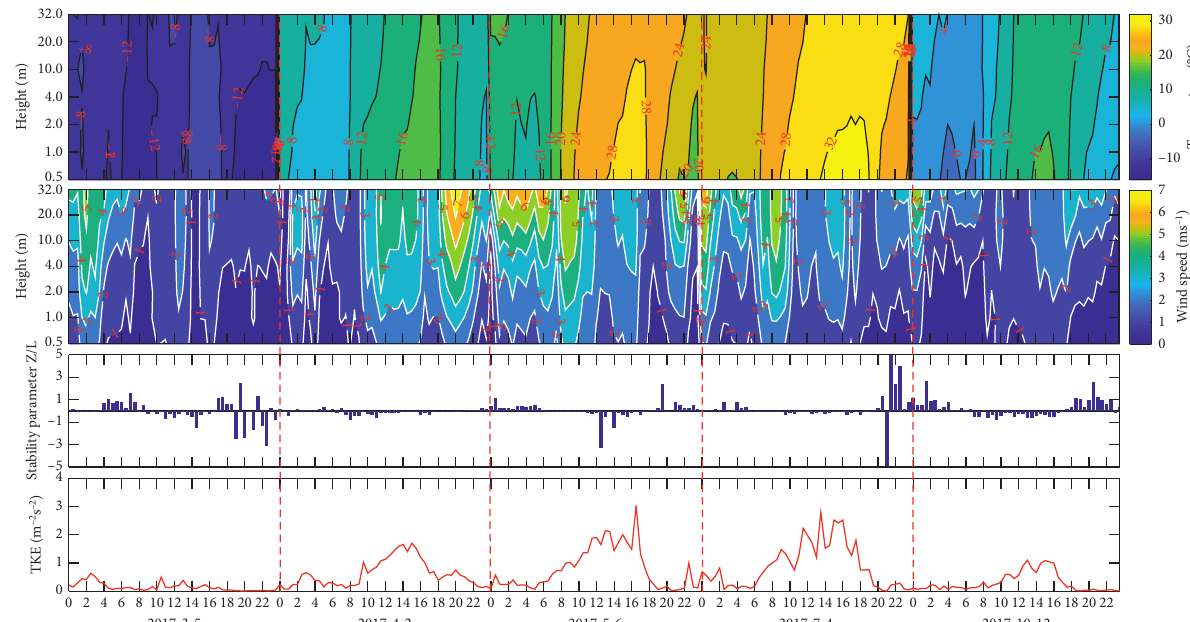
Figure 8: Temperature and wind speed profile under different surface